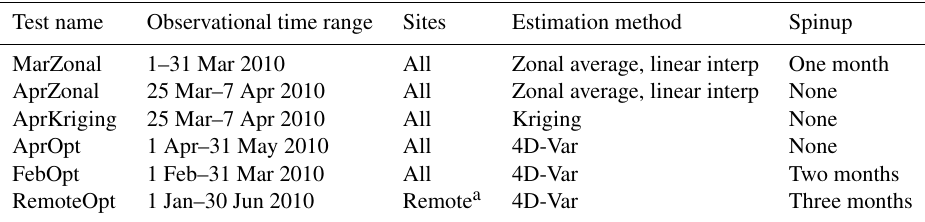
Figure 1. Global surface observing network for atmospheric N 2 O. Shown are surface discrete measurement locations for the NOAA Carbon Cycle and Greenhouse Gases (CCGG) network, the Commonwealth Scientific and Industrial Research Organisation (CSIRO) network, the National Institute of Water and Atmospheric Research (NIWA) network, and the Environment Canada (EC) network, as well as semi- continuous measurement locations in the NOAA Chromatograph for Atmospheric Trace Species (CATS) network, the Advanced Global Atmospheric Gases Experiment (AGAGE) network, and the KCMP tall tower site. Also shown are flight tracks from the HIPPO IV and V deployments. Table 1. The six initial conditions (for 1 April 2010) tested for N 2 O, including the time range of observations used, observation sites included, interpolation or optimization method used, and length of